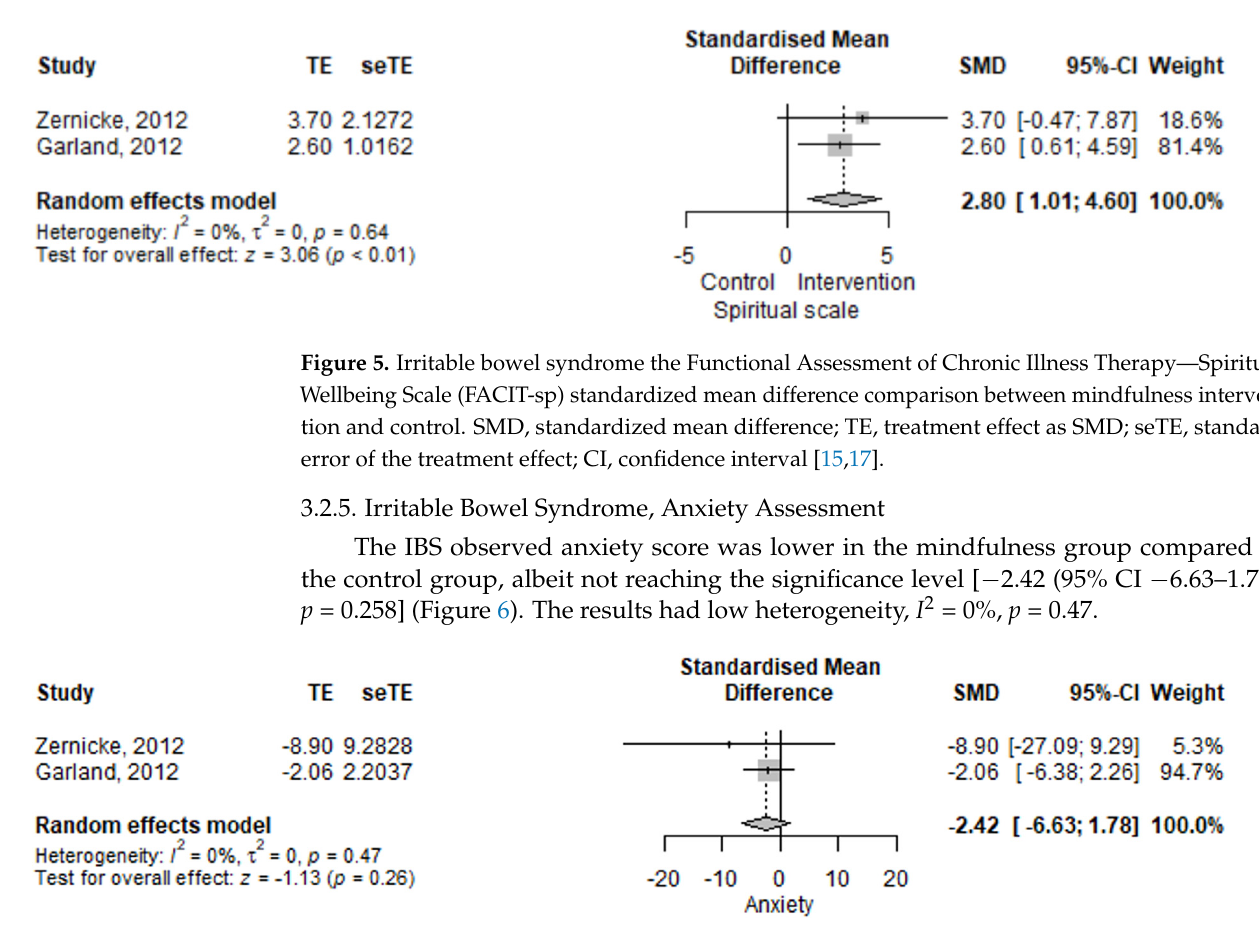
tween mindfulness intervention and control. SMD, standardized mean difference; TE, treatment effect as